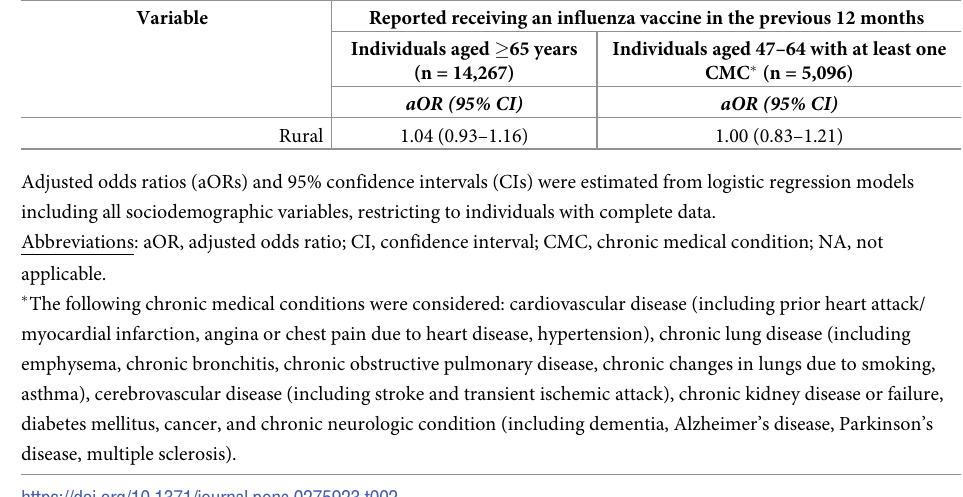
PLOS ONE | https://doi.org/10.1371/journal.pone.0275923 October 14,